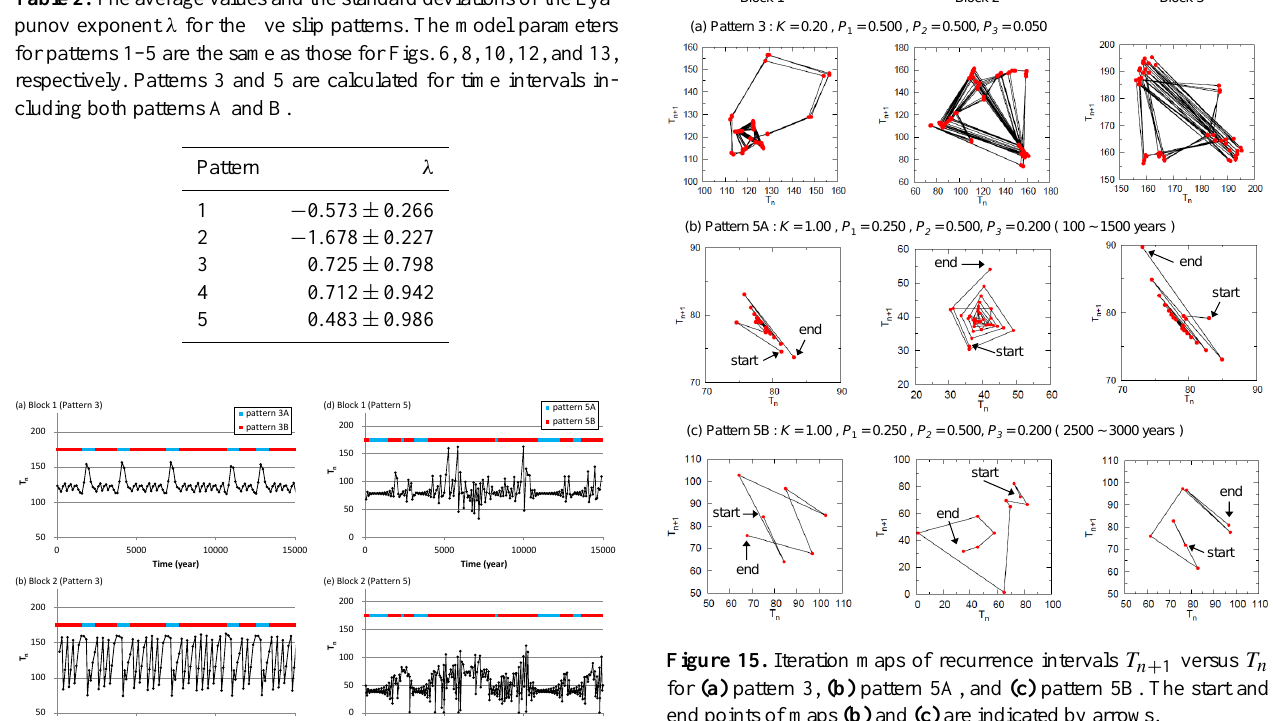
Table 2. The average values and the standard deviations of the Lya- punov exponent λ for the five slip patterns. The model parameters for patterns 1–5 are the same as those for Figs. 6, 8, 10, 12, and 13, respectively. Patterns 3 and 5 are calculated for time intervals in- cluding both patterns A and B.